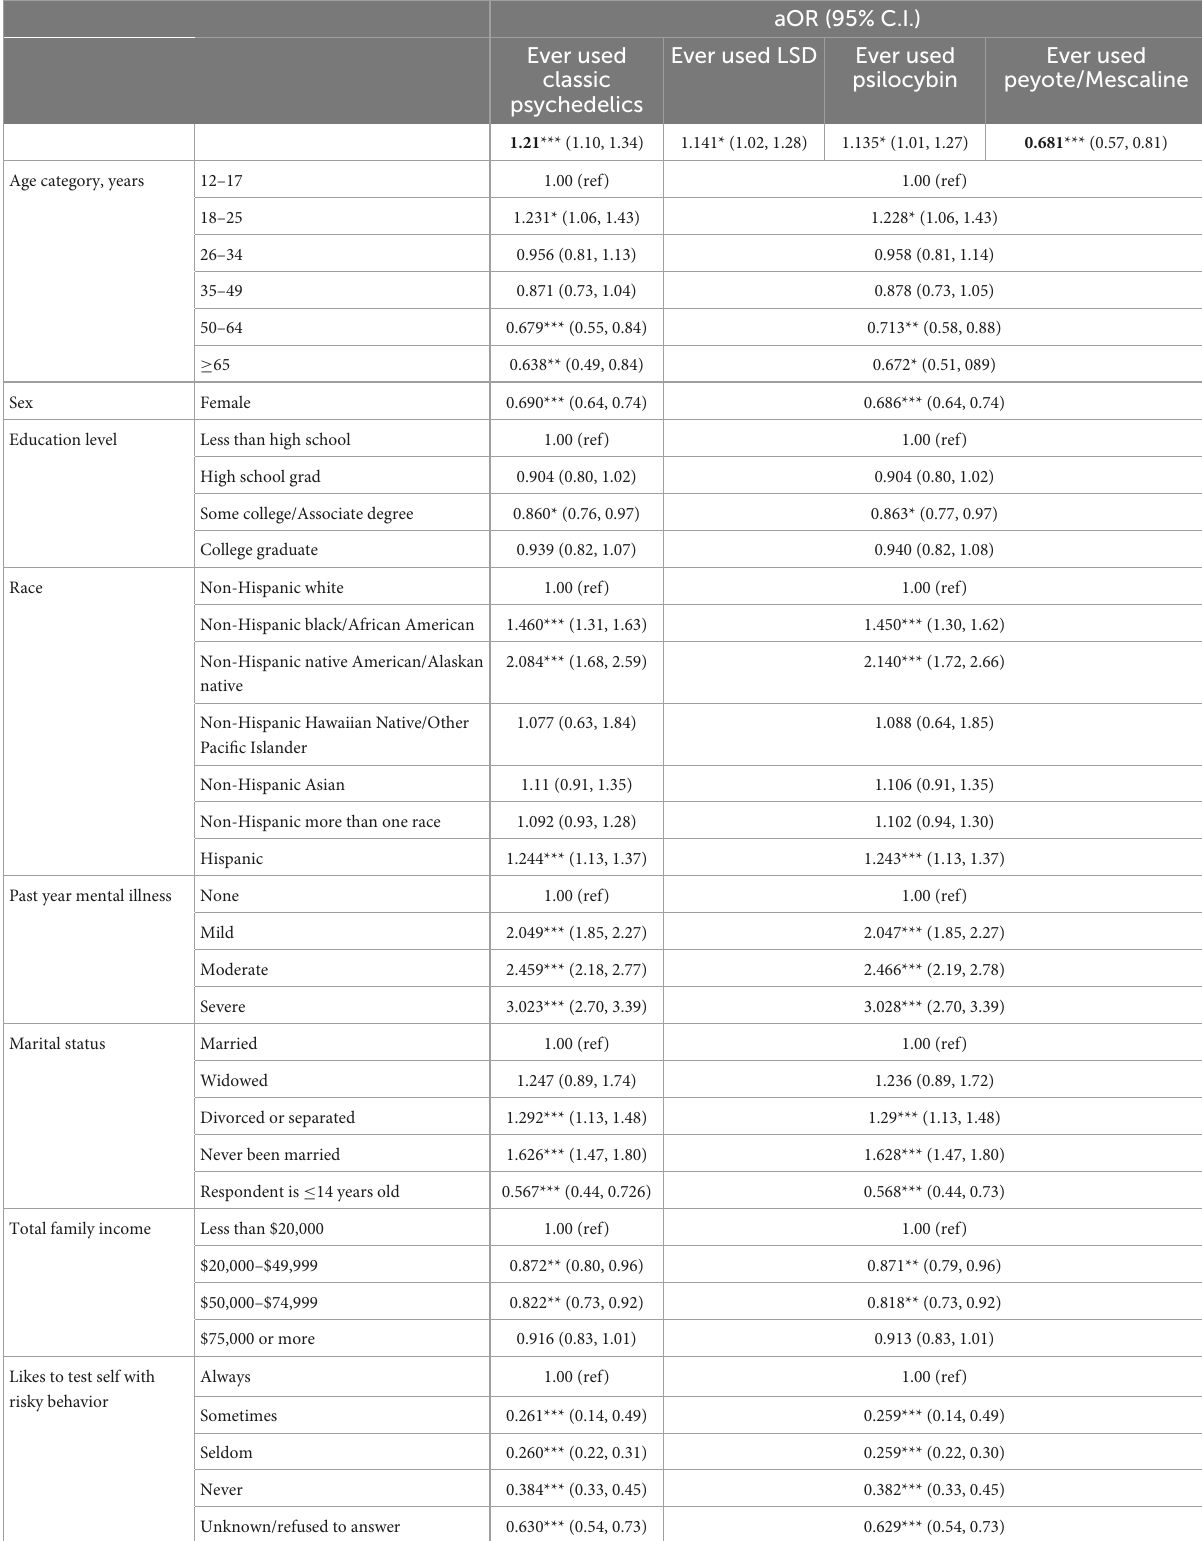
TABLE 2 Results of logistic regression showing adjusted odds ratio for past year substance use disorder among users of any of the classic psychedelics in this study, as a class of substances and individually.